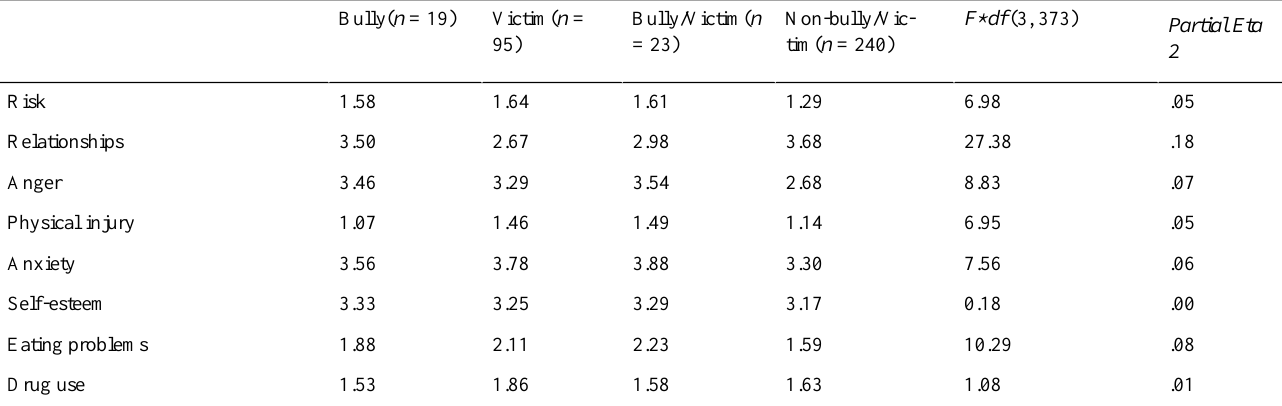
Table 4. Mean scores of health experiences subscales for bullies, victims, bully/victims, and